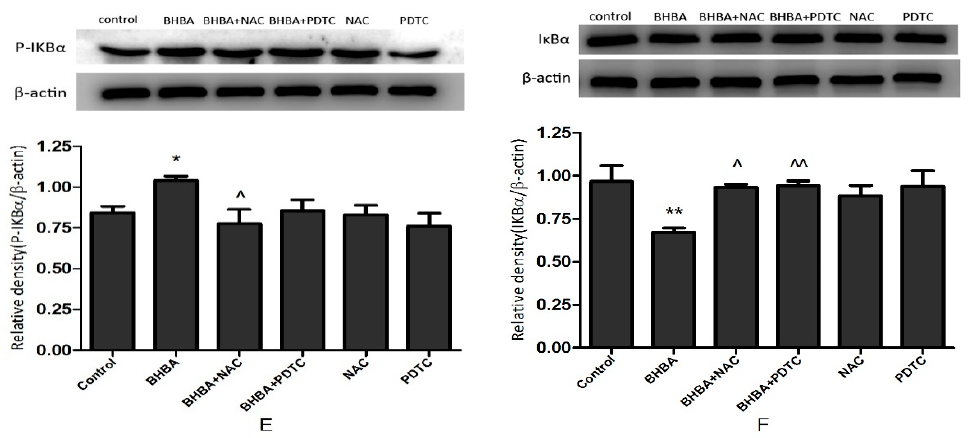
Figure 5. NF- κ B signal protein expression. ( A – C ) BEND cells were treated with 0.6 mM PA, 0.6 mM